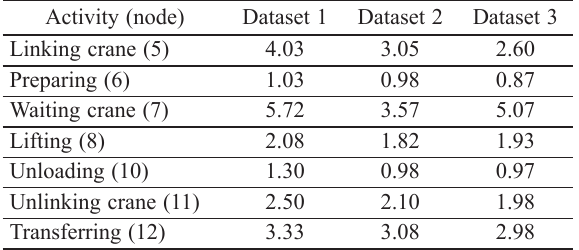
Table 3. Duration of activities in the lifting process